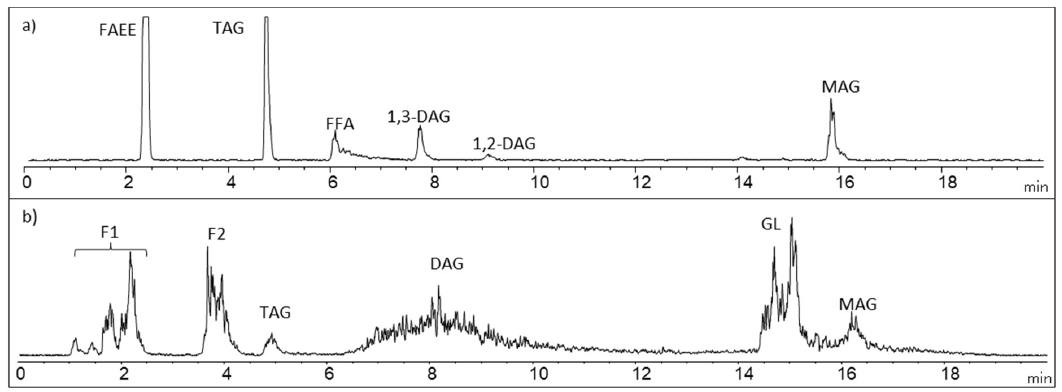
Figure 3. Example of lipid profile of standard mixture ( a ), extracted Isochrysis galbana by PLE at 100 ◦ C ( b ), determined by HPLC-ELSD. Fatty acids ethyl ester (FAEE); Triacylglycerol (TAG); Free fatty acid (FFA); 1,3-diacylglycerol (1,3-DAG); 1,2-diacylglycerol (1,2-DAG); Monoacylglycerol (MAG); Fraction 1 (F1) and Fraction 2 (F2); Glycolipid (GL).